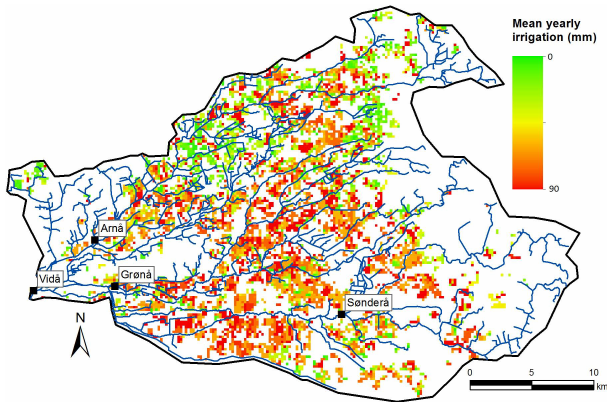
Fig. 3. Land use in the catchment.